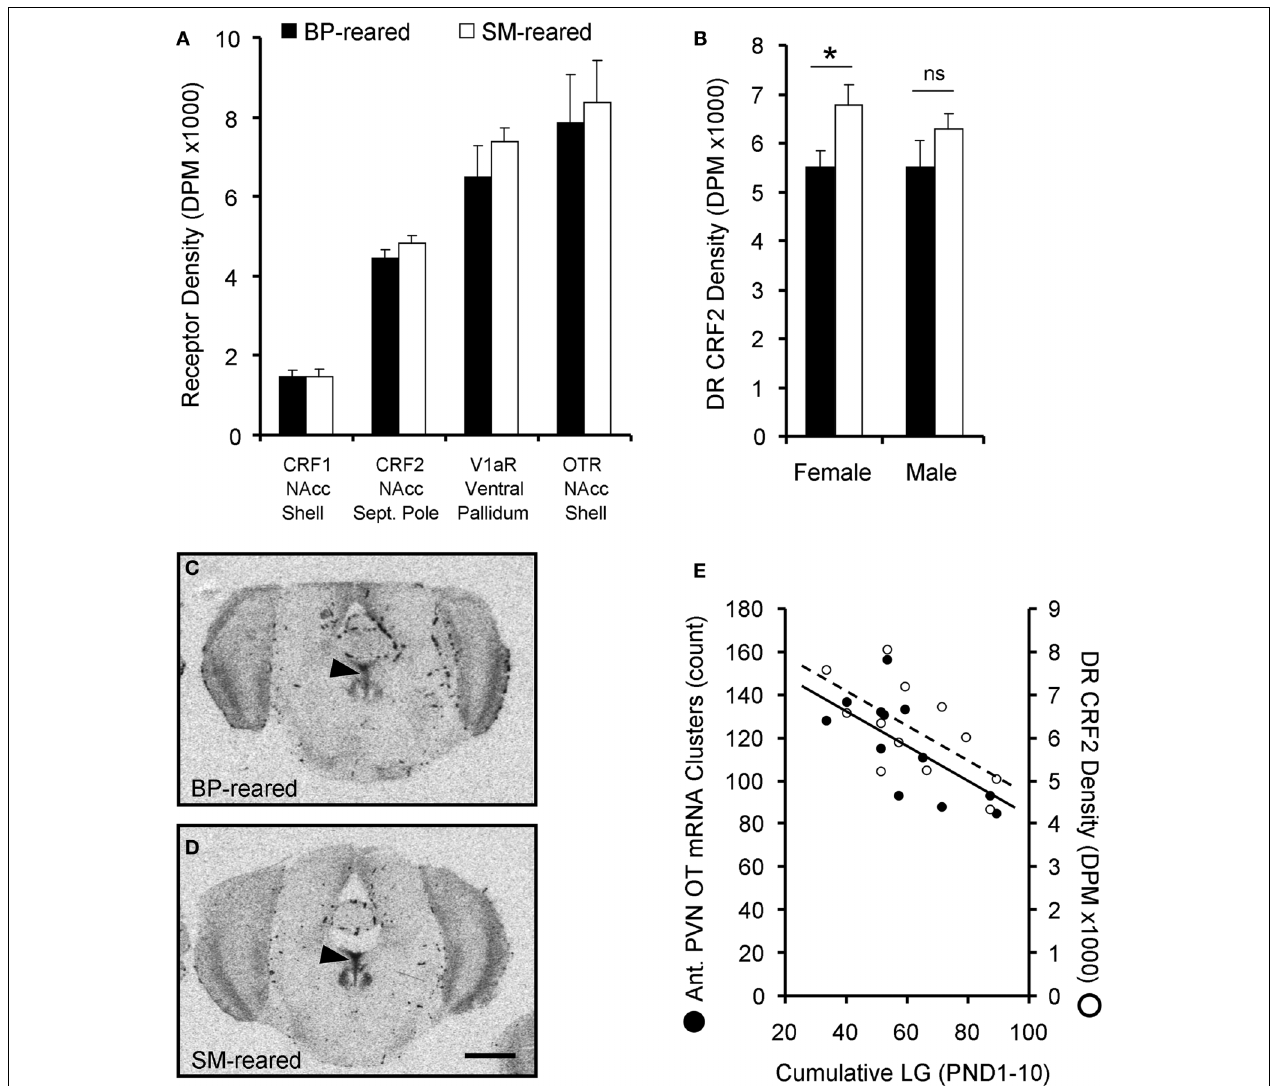
and (D) show representative coronal sections of dorsal raphe CRF2 from BP- and SM-reared females, respectively. Arrow-heads identify the DR and scale bar represents 1 mm. (E) graphically depicts the correlational relationship between early life licking and grooming (LG) and two neuropeptide system markers: the number OT mRNA clusters in the anterior PVN and the density of CRF2 in the DR. (cid:132) , BP-reared adult offspring; (cid:133) , SM-reared adult offspring. (cid:122) , LG/OT correlation ( R = − 0.611); (cid:124) , LG/CRF2 correlation ( R = − 0.652). * P < 0.05, ns = not signifi